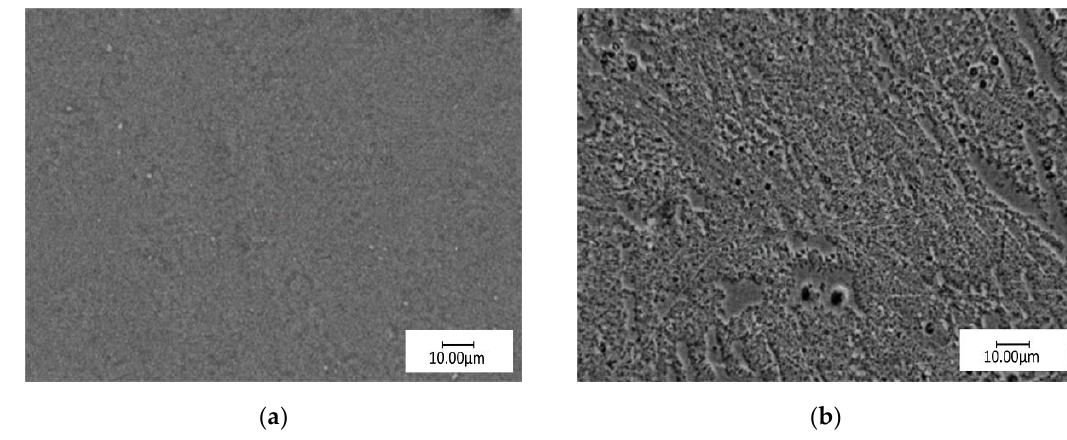
Figure 11. Examples of surface topography of M2 sample group ( a ) before; ( b ) after pitting corrosion test .